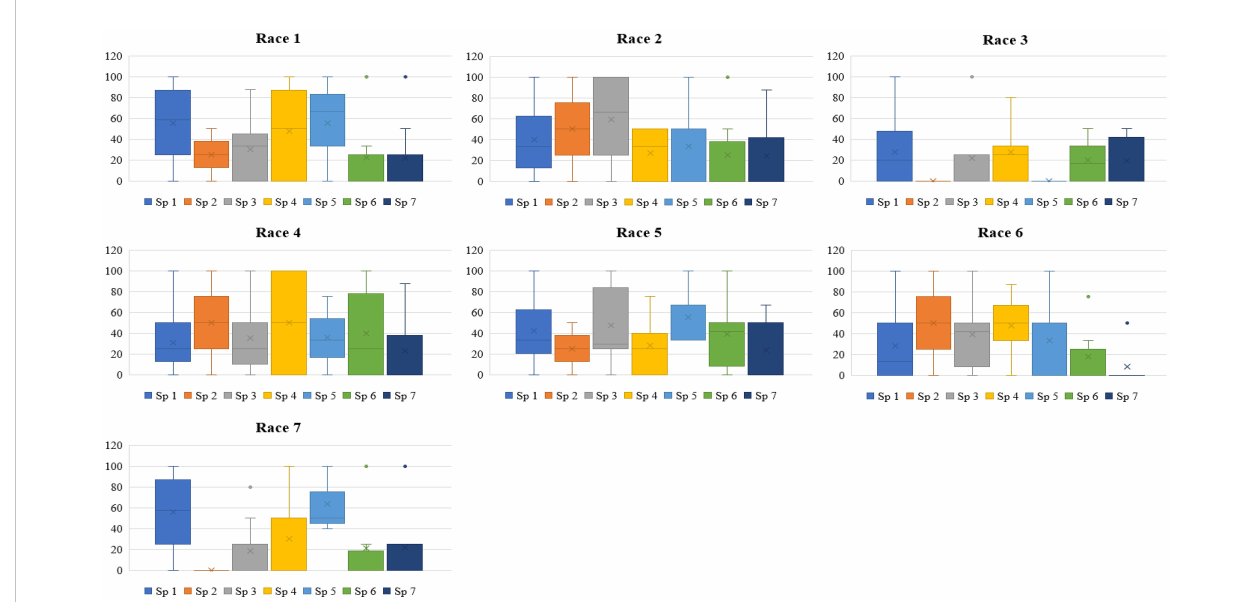
FIGURE 2 Box plot depicting disease incidence of each species of lentil against each race of Fusarium oxysporum f. sp. lentis screened during 2021-2022. Sp1, Lens culinaris sub sp. culinaris ; Sp2, L. c. subsp . tomentosus; Sp 3, L. c sub sp. orientalis ; Sp 4, L. c. sub sp. odemensis ; Sp 5, L. lamottei ; Sp 6, L. nigricans ; Sp 7, L. ervoides . Race 1, MP-2; race 2, UP-9; race 3, RJ-8; race 4, DL-1; race 5, CG-5; race 6, UP-12; race 7,